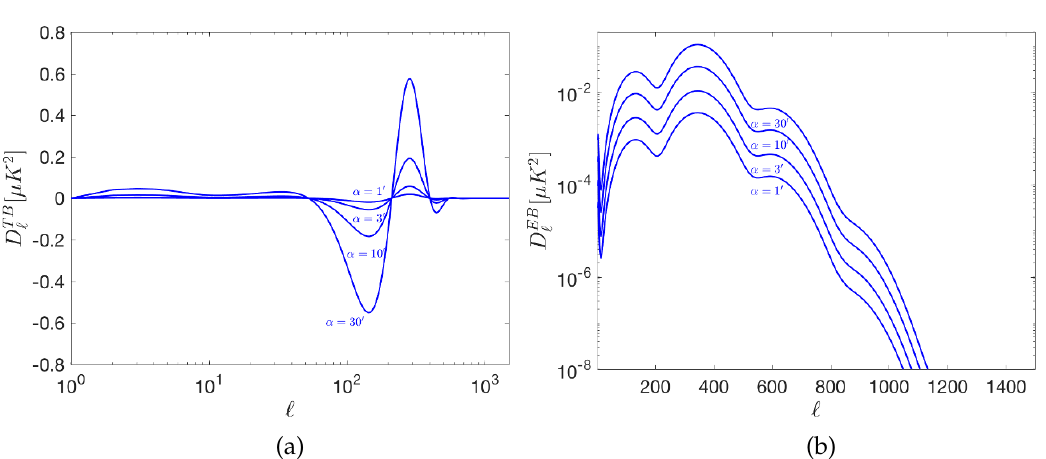
Figure 3. Systematic errors in the TB ( a ) and EB ( b ) angular power spectra per logarithmic interval produced by polarization angle errors. The spurious signal produced by 30, 10, 3 and 1 arc-minutes of polarization rotation are represented by the blue curves. The same assumptions of Figure 2 have been